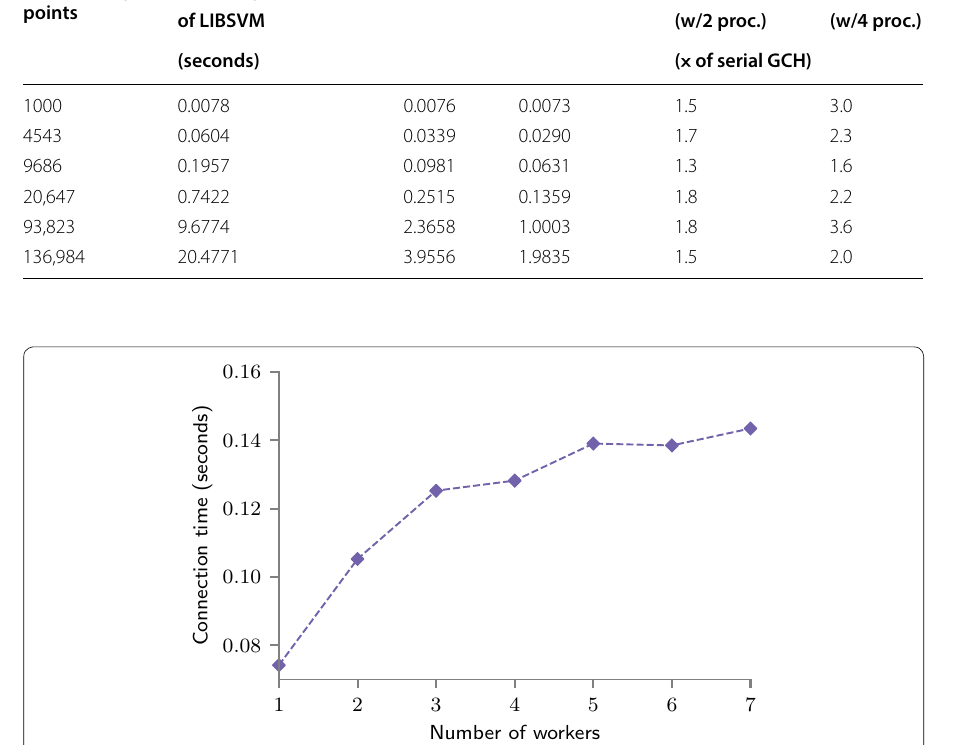
Fig. 26 Performance of the designed connection